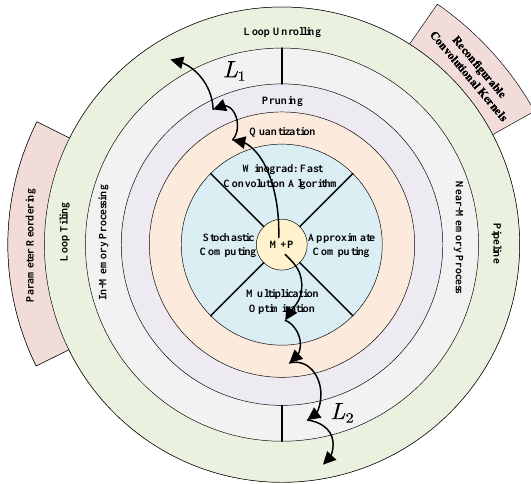
Figure 14. Technical route design. The normal acceleration scheme usually involves different gradations from the bit width of weights to the selection of different platforms and models. In this process, several techniques which are listed on the figure will be introduced. They can be chosen individually but tight connections will be built in the final